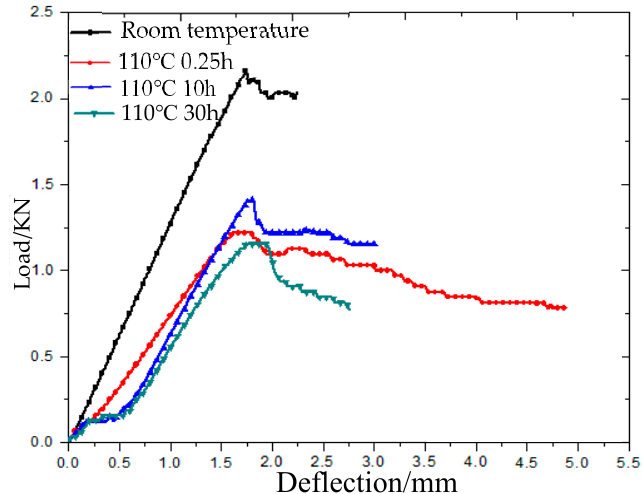
Figure 3. Deflection–load curve of 3Dim–5Dir braided composites after bending at 110 °C.